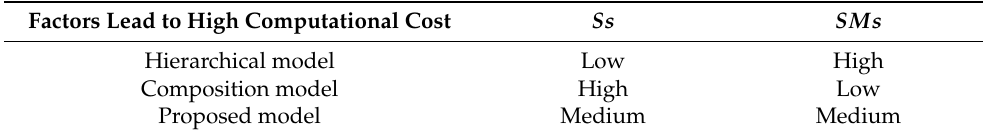
Figure 7. SMs generated by the proposed models and the others. Table 5. The summary of the comparison